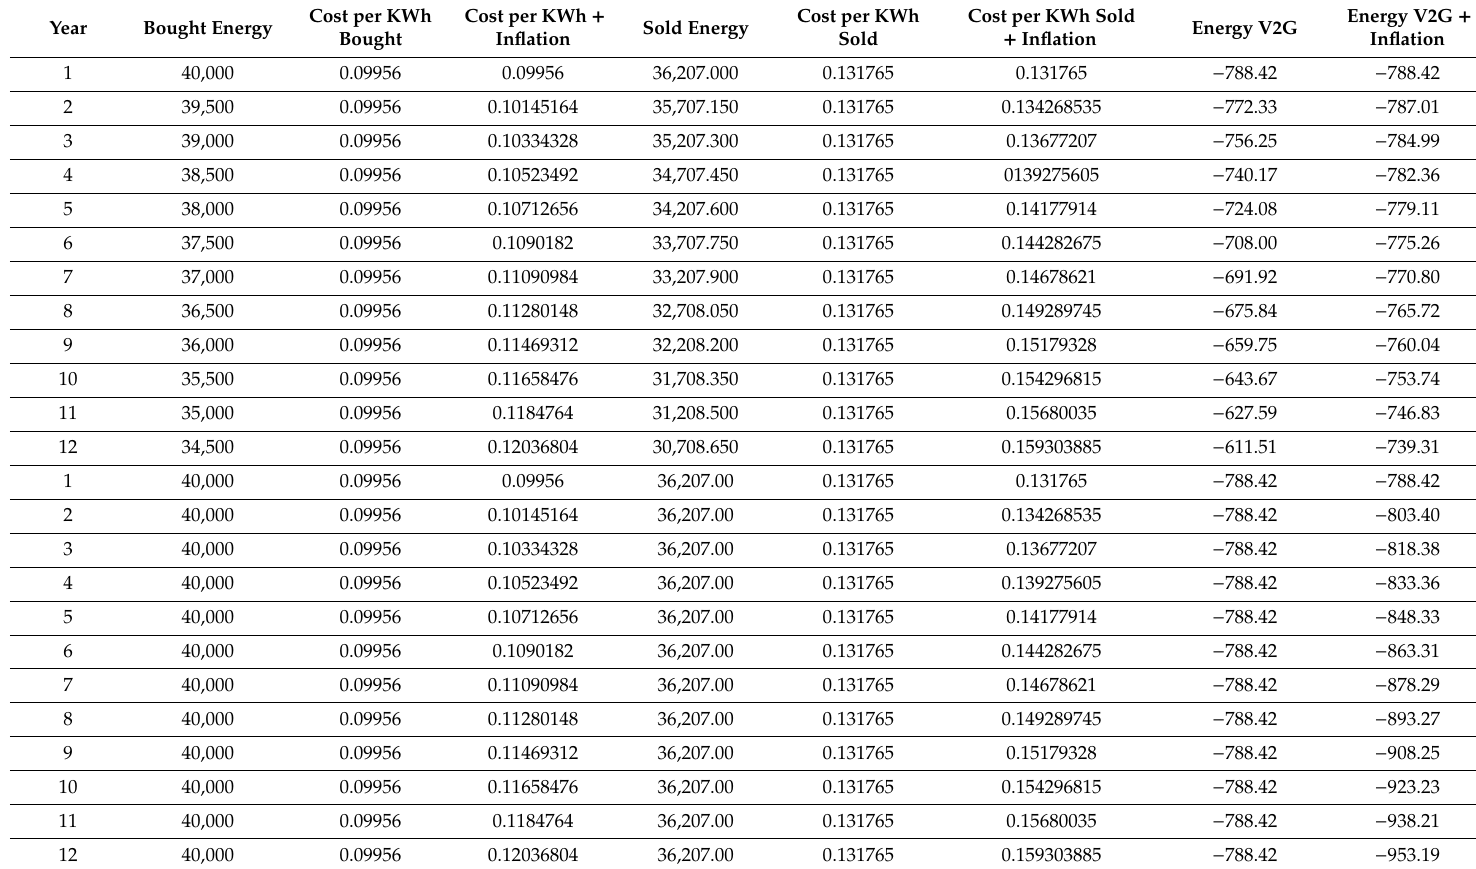
Table A6. Energy costs / profits with and without yearly degradation (frequent